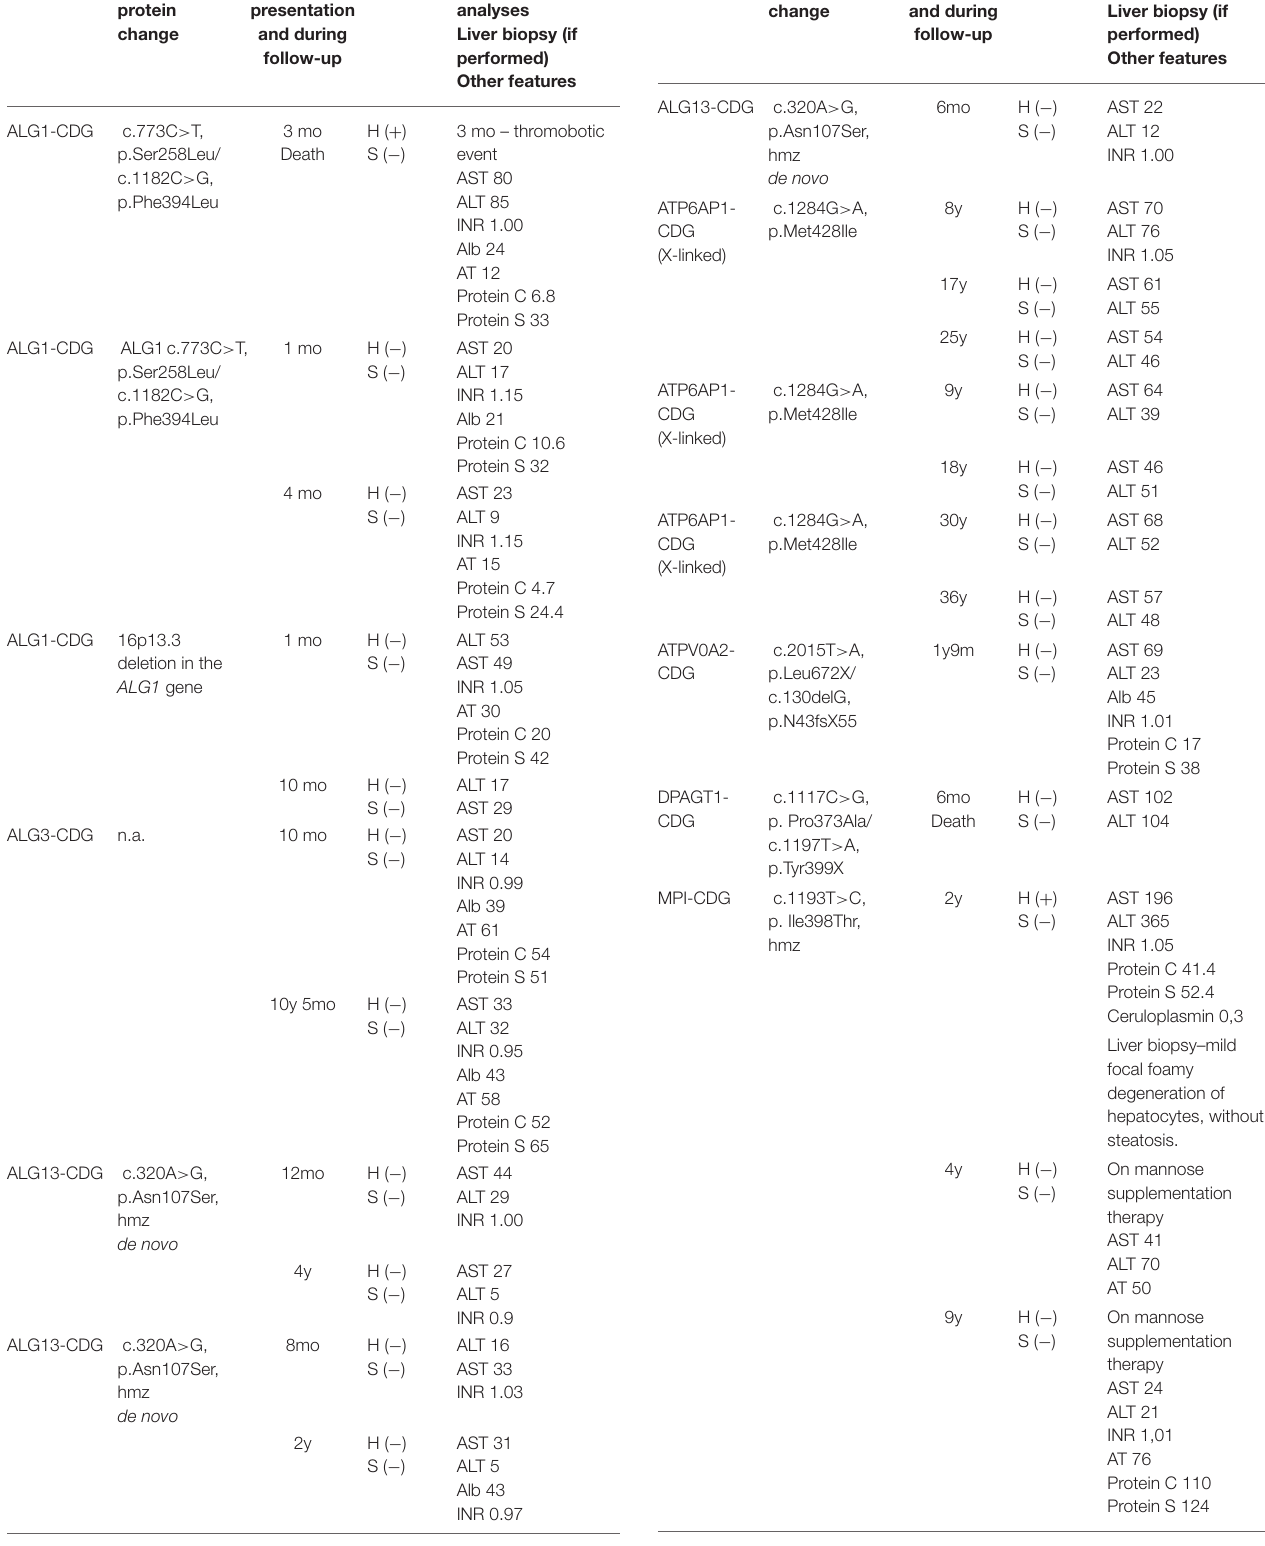
TABLE 1 | Biochemical and histological characteristics of liver disease in study patients with CDG/NGLY1-CDDG defined molecularly. CDG/CDDG Mutation and protein